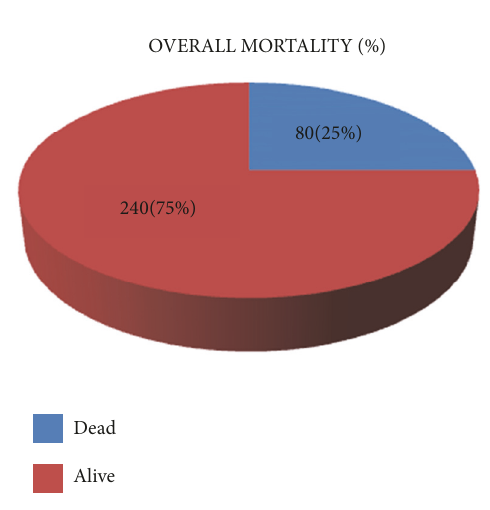
Figure 2: Overall mortality